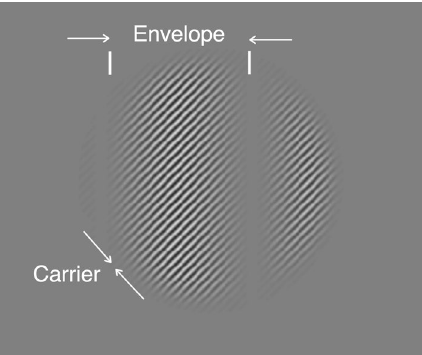
Figure 1. Example contrast modulation (CM) stimulus. The stimulus, presented within a cosine-tapered circular window of 3.5° of visual angle, consists of a high spatial frequency contrast-reversing carrier grating (right-oblique) whose contrast is modulated by a low spatial frequency, vertical sinewave